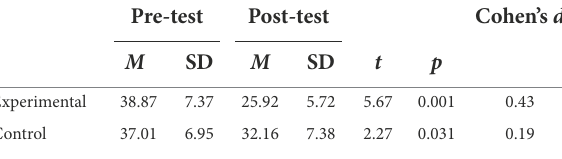
TABLE 4 Paired samples t -test results, examining the differences between the pre- and post-tests of the two groups on the on the writing anxiety.